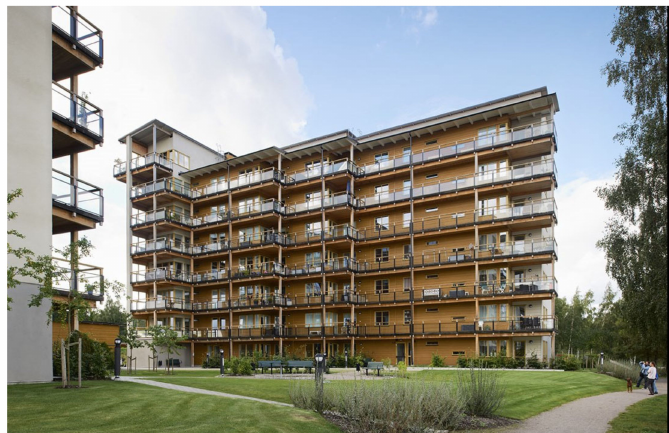
Figure 3. One of the four Limnologen buildings, Photograph by Åke E:son Lindman [47]. The Limnologen buildings (with seven storeys in timber only) are located in an area with a low seismic activity ( a g ,475 = 0.02 g). Therefore, the basic wind load ( v b ,0 = 25 m/s)